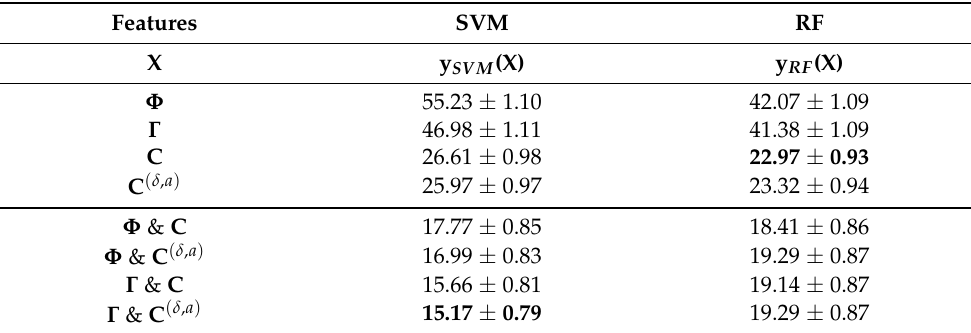
Table 2. Heartbeat sequence misclassification rate [%] for the university cohort. The best results are presented in bold.